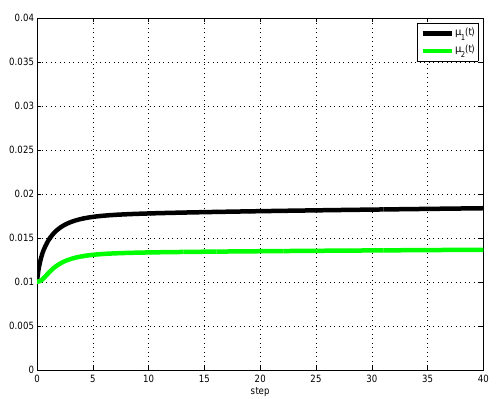
Figure 3. The control gains of controller ( 7 ) .